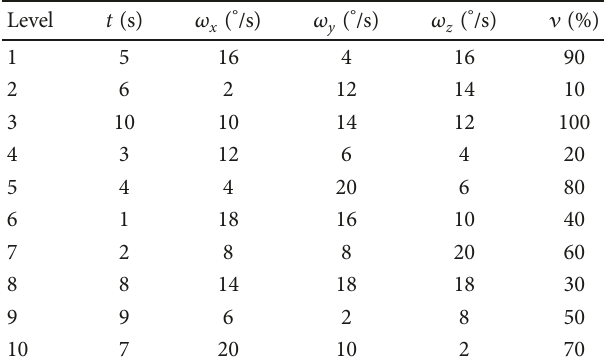
Table 7: Five factors and ten levels uniform test table.